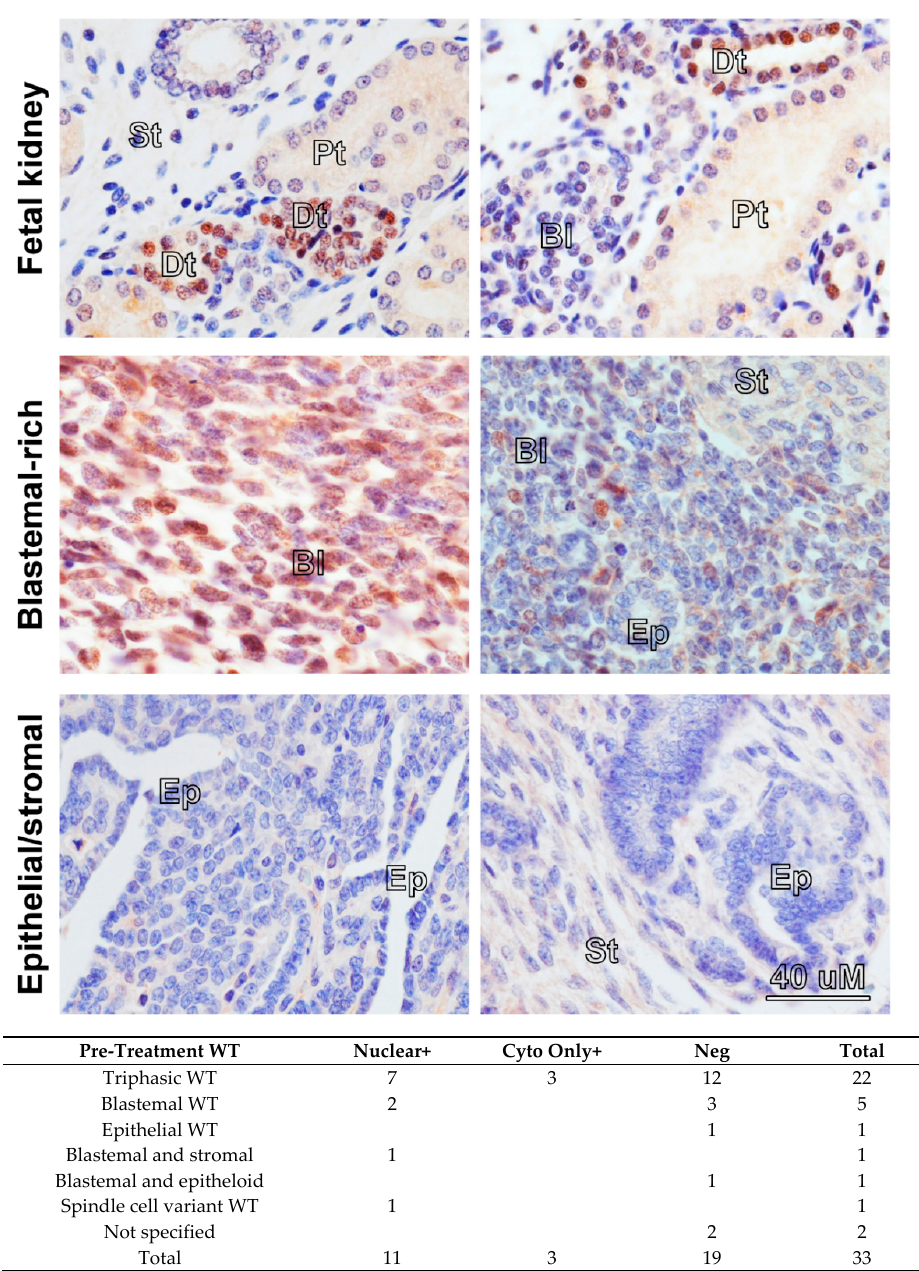
Figure 1. Immunohistochemistry in fetal kidney and Wilms’ tumours (WT) reveals a blastemal expression for MYCN protein in tumours. All images were taken at the same magnification. MYCN expression was detected in the distal tubules (Dt) in a 13-week-old fetal kidney, while the blastema (Bl), stroma (St) and proximal tubules (Pt) were negative. Blastemal-rich WT showed positivity in the blastemal component. Epithelial (Ep) and stromal structures did not show any expression of MYCN protein. A table summarizing positive MYCN staining in the nucleus or the cytoplasm only in WT, according to histology, is shown